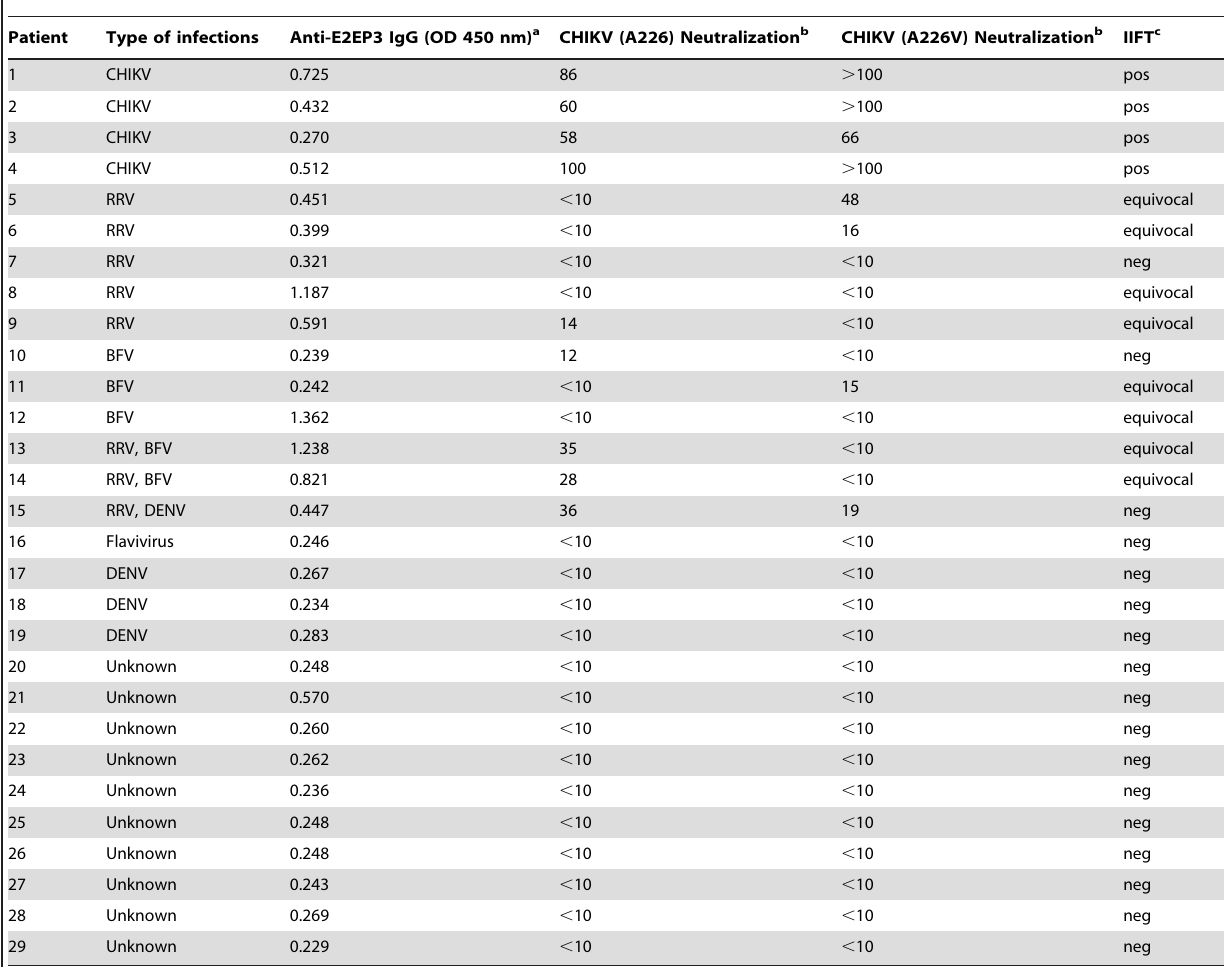
a Anti-E2EP3 IgG antibody titer was determined by peptide-based ELISA from serum samples with different type of infections. O.D. values . 0.216 were classified as E2EP3 cross-reactive samples. b Antibody titer above 1:10 indicates presence of neutralizing activity to CHIKV. c CHIKV detection was considered as equivocal if the weak immunofluorescence was observed from the BIOCHIP.